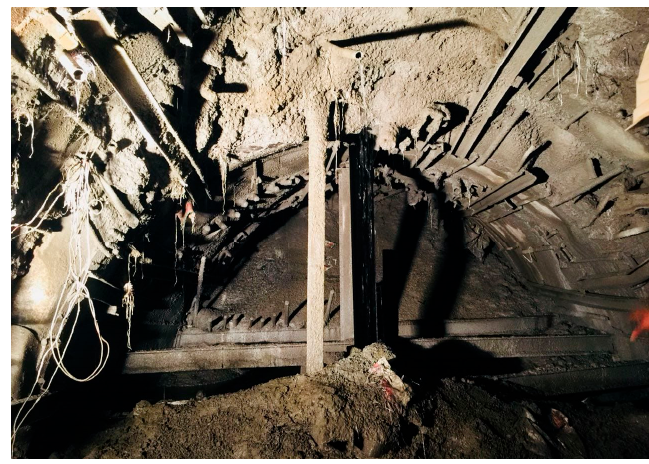
Figure 6. Temporary vertical struts for crown settlement control in DKHP.